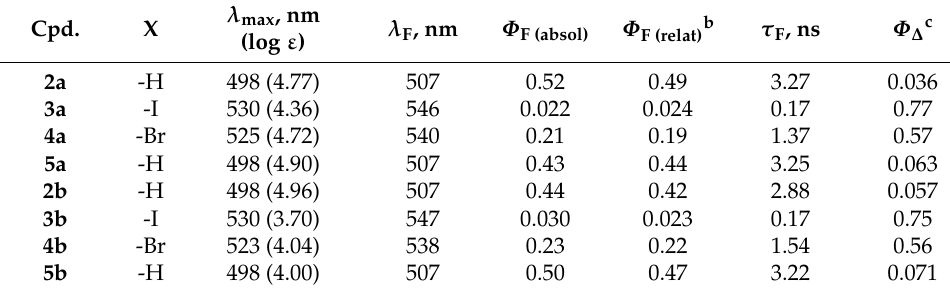
Table 1. Photophysical data of studied compounds in MeOH a